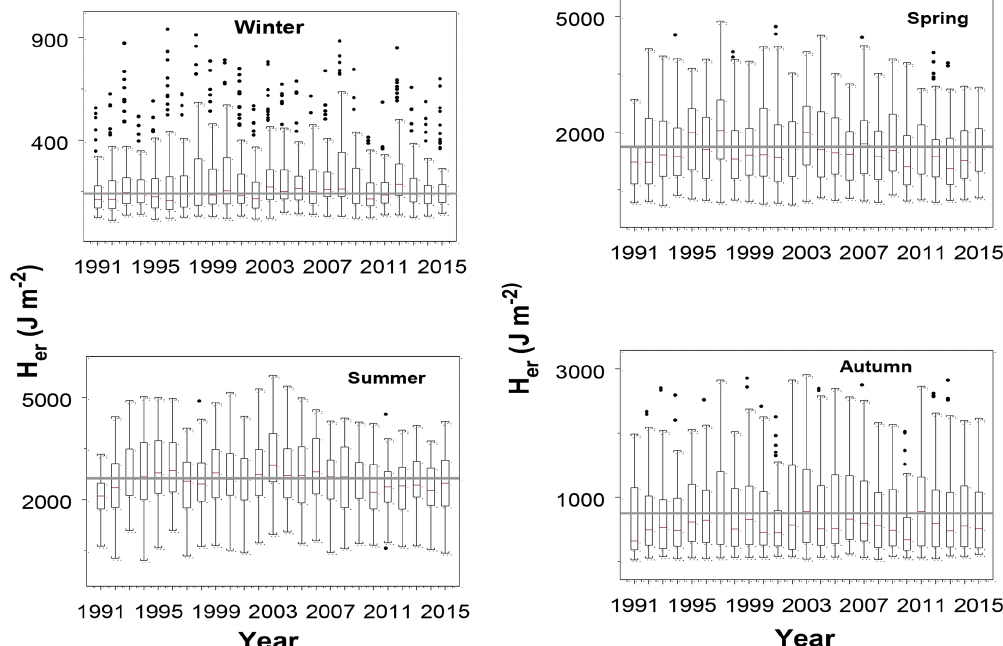
Figure 1. Box plots of the daily H er data for each season at the Chilton site between 1991 and 2015 (grey solid line represents the mean value for each season).